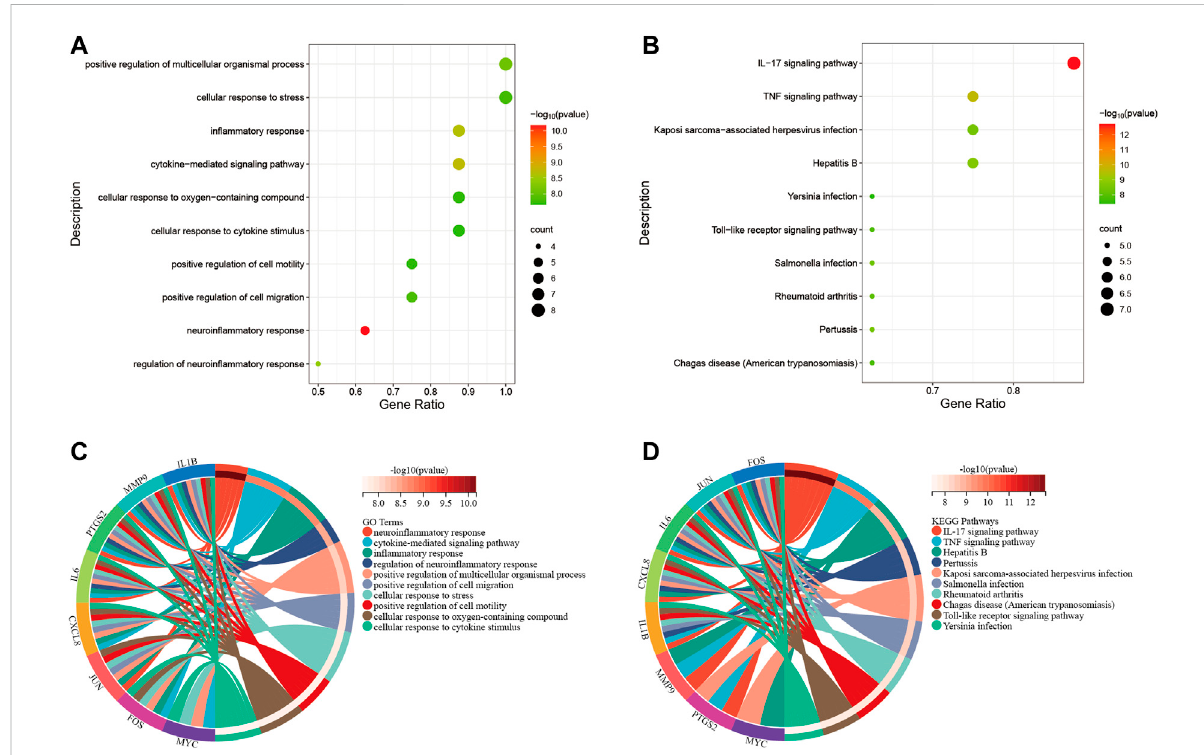
FIGURE 8 Functionalenrichmentanalysis. (A) ,bubblediagramthatshowsGOanalysisof8hubgenes. (B) ,bubblediagramthatshowstheKEGGanalysisof 8 hub genes. (C) , circle diagram to display the GO terms exactly enriched for each of the 8 hub genes. (D) , circle diagram to display the KEGG pathways exactly enriched for each of the 8 hub genes. Distinguish different enrichment terms with various